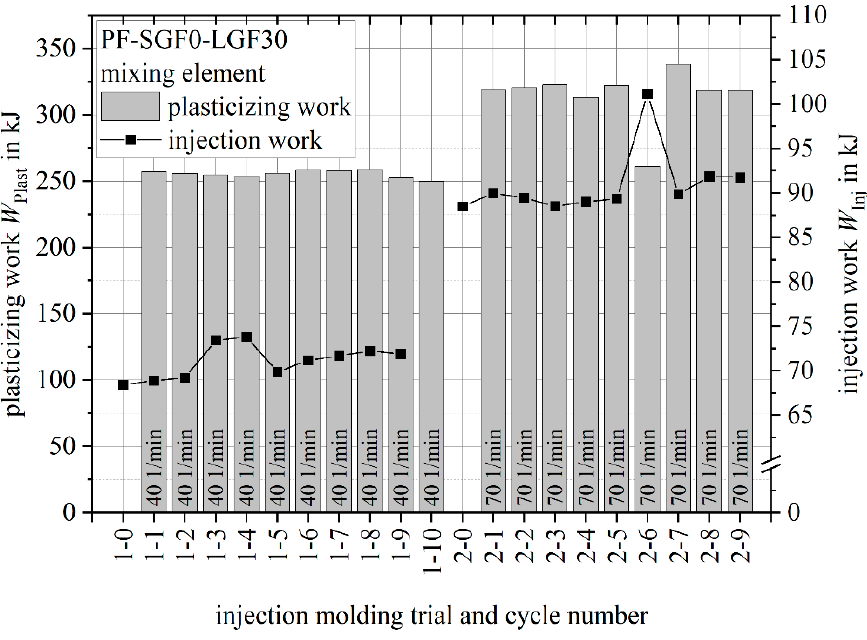
Figure 9. Plasticizing work and injection work for PF SGF0 LGF30 process stability